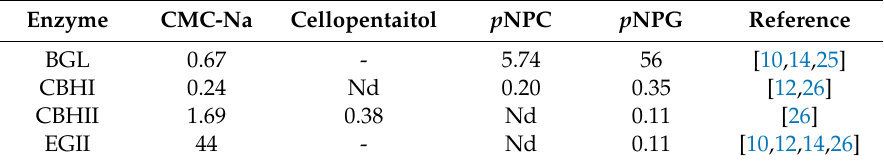
Table 2. Specific activities (U/mg protein) of the cellulase enzymes on model substrates. The underlined values are the specific activities expected (based on the literature) for each enzyme tested.